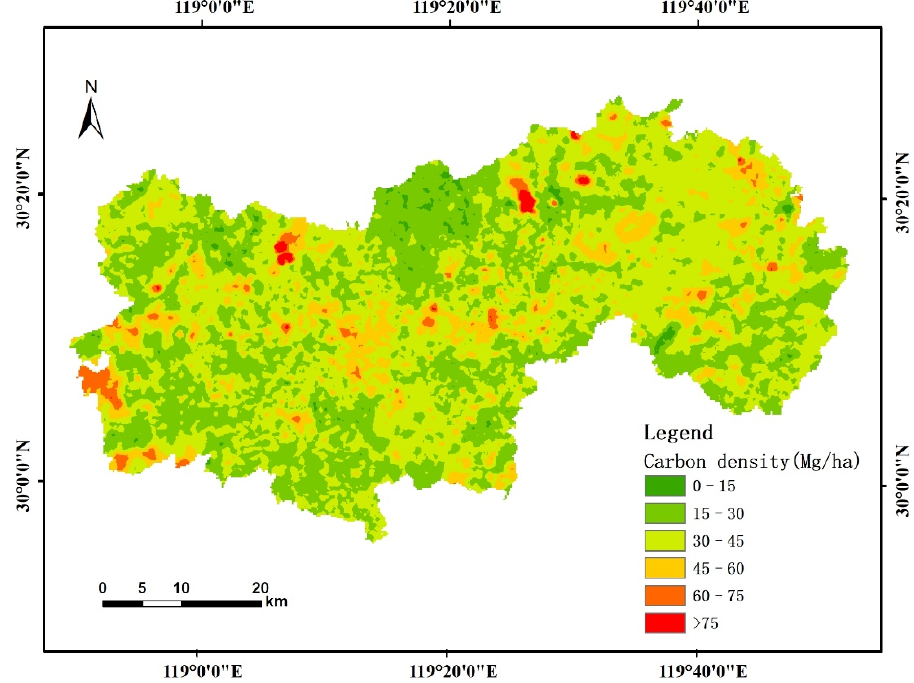
Figure 7. Map showing the carbon-density distribution in the study area determined using CNN algorithms.